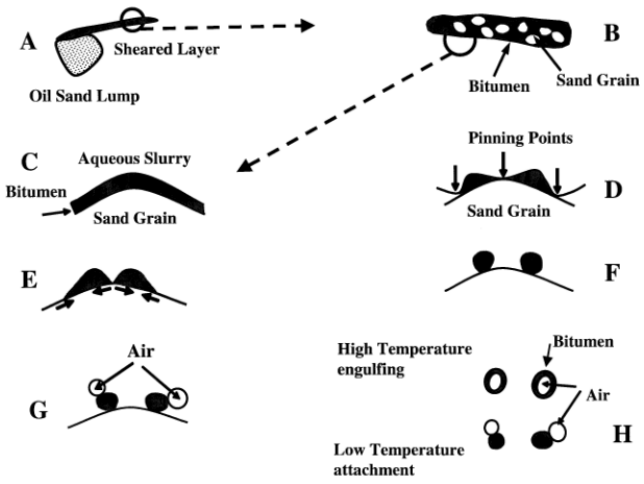
Figure 3. The separation processes of unconventional heavy oil ores by HWBE. Reprinted with permission from Ref. [18]. Copyright 2008, copyright Wiley. More details on Copyright and Liscensing are available via the following link: https://onlinelibrary.wiley.com/.